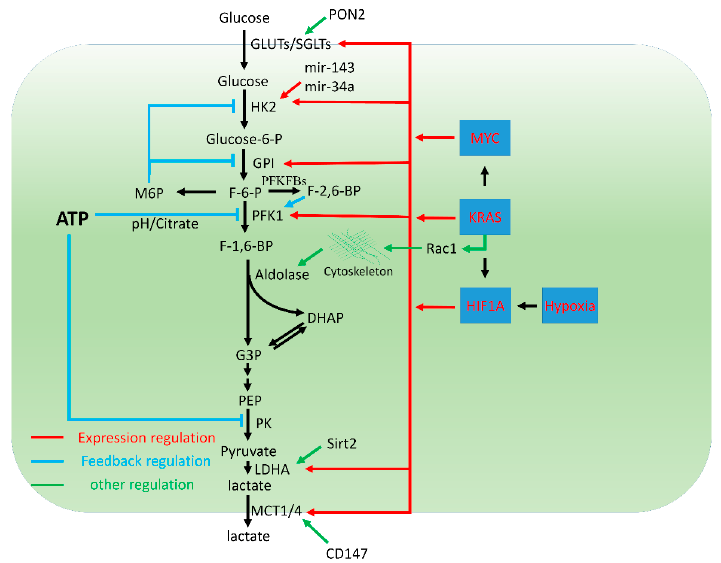
Figure 1. Regulation of glycolysis in PDAC.